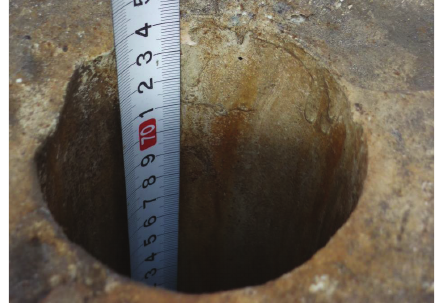
Figure 3: Core-drilled sample.